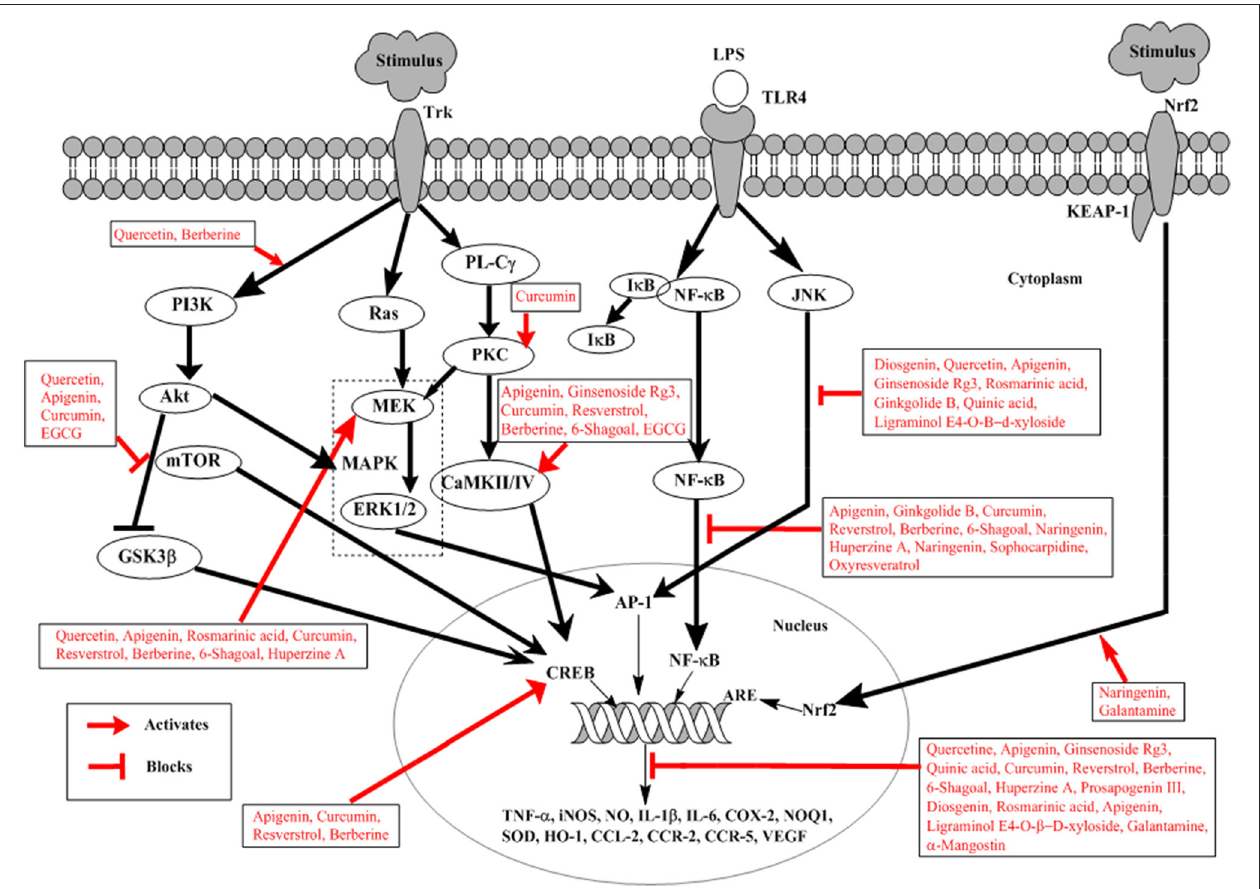
FIGURE 2 | Schematic representation of natural products involved in neuroprotection against Alzheimer’s disease. External stimulus binds to Trk receptor activating PI3K/AKT, Ras/MAPK, and PL-C γ pathways. LPS binds to TLRs activating NF- κ B and JNK signaling. External stimulus releases Nrf2 from Nrf2-KEAP-1 complex and activates ARE. Trk, tyrosine kinase receptor; LPS, lipopolysaccharide; TLRs, toll-like receptors; PI3K, phosphatidylinsoitol-3-kinase; MAPK, mitogen-activated protein kinase; mTOR, mammalian target of rapamycin; ERK, extracellular signal-regulated kinases; Nrf2, nuclear factor e2-related factor 2; KEAP-1, Kelch-like ECH-associated protein-1; MEK, mitogen-activated protein kinase; PL-C γ , phospholipase C γ ; NF- κ B, nuclear factor-kappa B; PKC, protein kinase C; JNK, c-Jun N-terminal kinase; ARE, Antioxidant response element; CREB, cyclic adenosine monophosphate response element binding protein; I κ B, inhibitory kappa B; CaMKII/IV, Ca2 + -calmodulin kinase II/IV; GSK3 β , glucose synthase kinase-3 β . Diosgenin, Prosapogenin III, Quercetin, Apigenin , Ginsenoside Rg3, Rosmarinic acid, Ginkgolide B, Limonoid, Quinic acid, Curcumin, Resverstrol, Berberine, 6- Shagoal, Ligraminol E4- O - β -d-xyloside, Huperzine A, Sophocarpidine, Naringenin, Epigallocatechin-3-galate (EGCG), Oxyresveratrol, α -Mangostin,